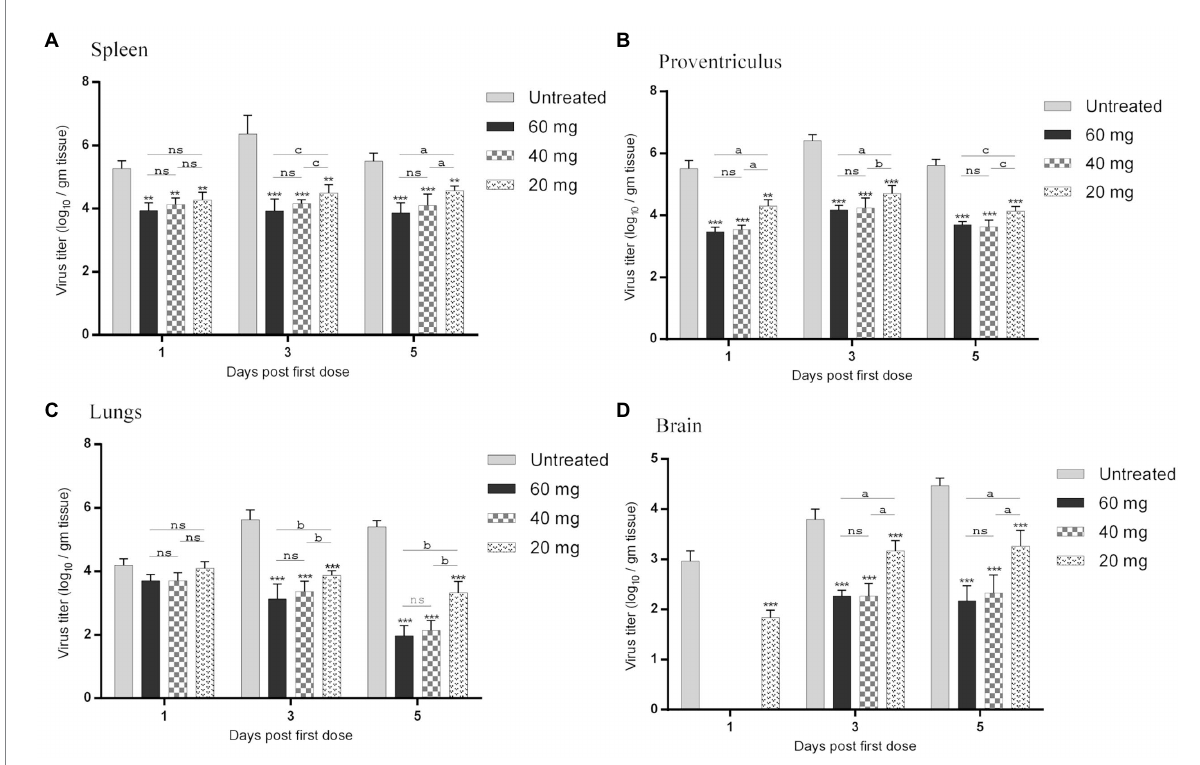
FIGURE 4 NDV load in organs resembling the (A) lymphatic (spleen), (B) digestive (proventriculus), (C) respiratory (lungs), and (D) nervous (brain) systems of experimentally infected chickens during and after treatment with 20, 40 and 60 mg/k.g BW n -docosanol. The organs were collected at 1, 3 and 5 days post the first n -docosanol dosage injection. The titer of recovered NDV was determined by qRT-PCR. The letters a, b and c indicate a significant difference in the viral log10 value between the low, medium, and high n -docosanol dosage groups at the same time point ( value of p of <0.05). The asterisk indicates a significant difference in the viral log10 value between the untreated group and the high or medium or low dosage group at the same time point ( p < 0.01). ns represents the non-significant